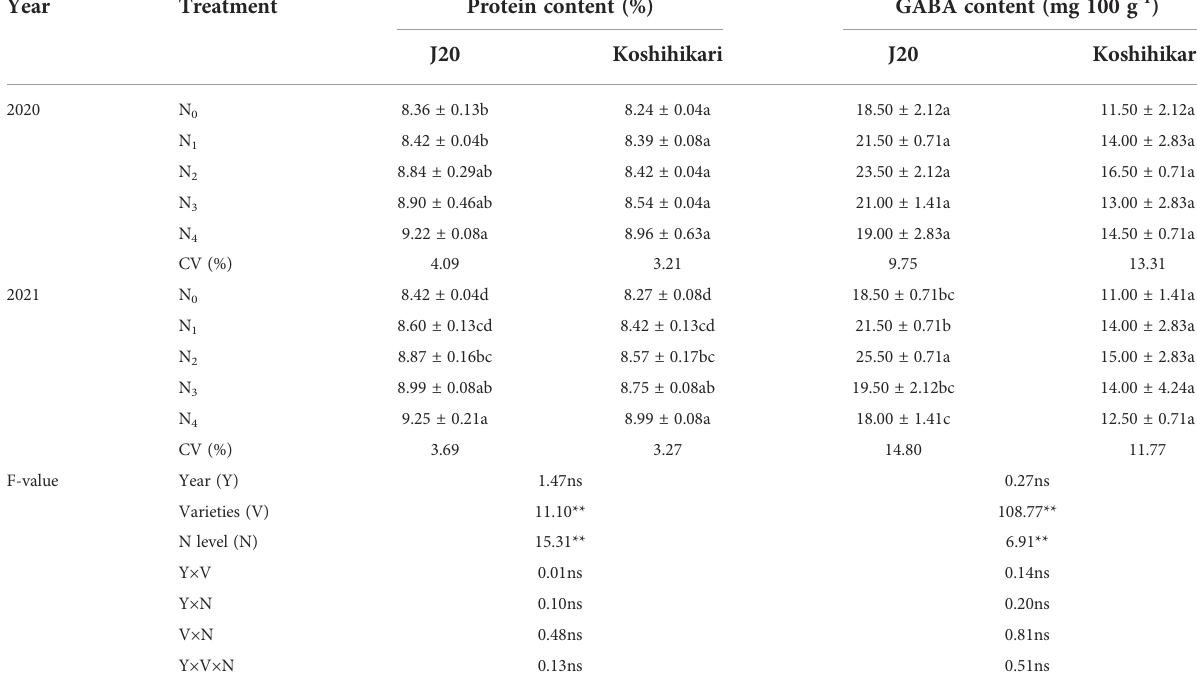
TABLE 5 Effects of N application rate on protein content and GABA content in brown rice fl our. Year